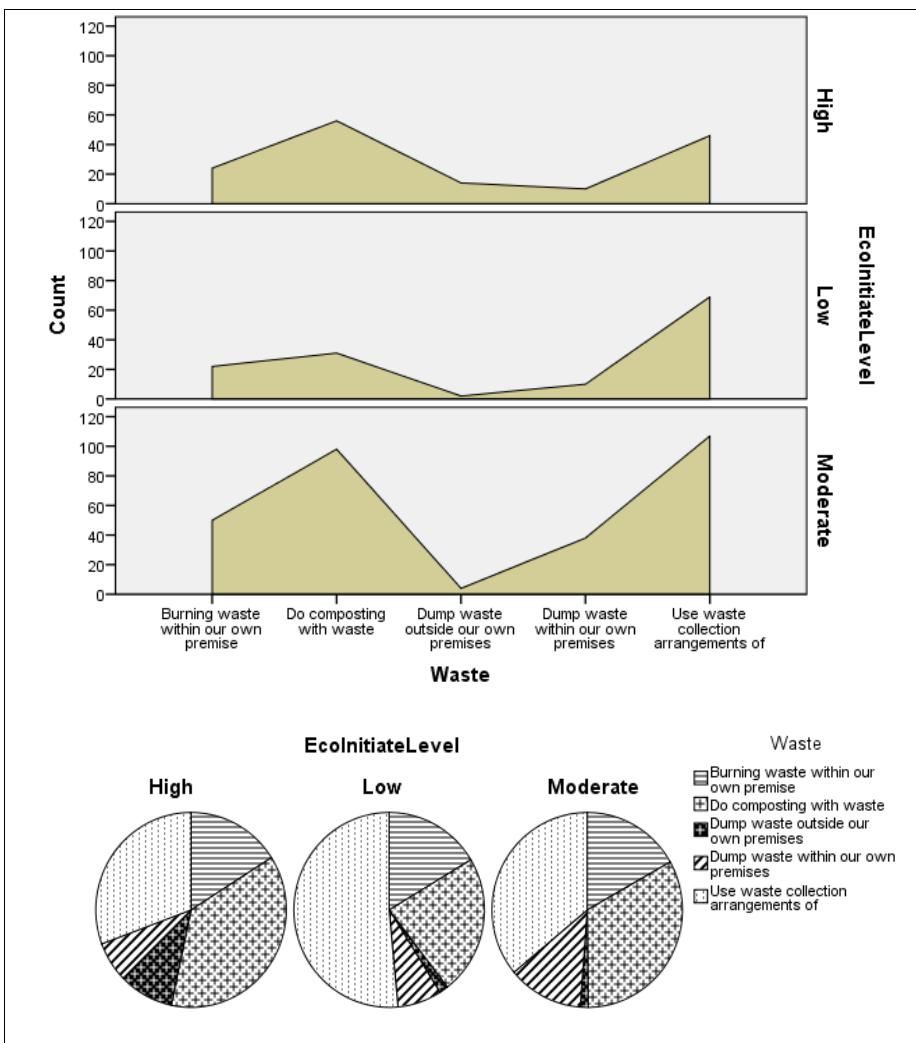
Figure 02: Eco-initiative levels and Waste disposal